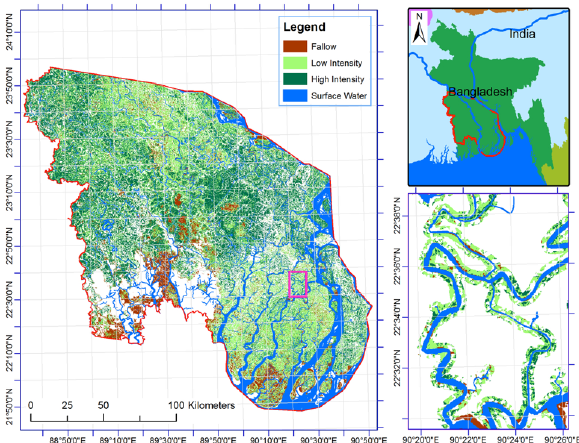
Figure 3: Land use intensity of cropland during the 2014 Rabi season in southern Bangladesh. The analysis was based on a series of Landsat 8 images acquired between December 31, 2013 and late March, 2014. At the lower right, a detailed view of the cropping intensity levels within a 385 m buffer is given.